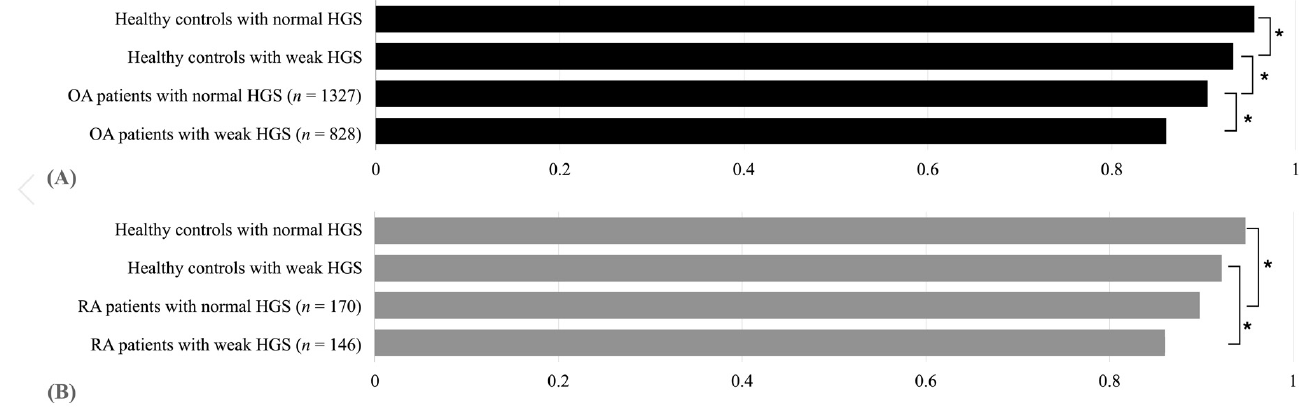
Figure 3. Subgroup analysis of EQ-5D index depending on HGS for patients with osteoarthritis ( A ) and patients with rheumatoid arthritis ( B ). Abbreviations: EQ-D5 European Quality of Life Scale-Five, HGS handgrip strength, OA osteoarthritis, RA rheumatoid arthritis. Adjusted for age, sex, BMI, low income, education ≥ 10 years, high-risk drinking, current smoking, aerobic physical activity, DM, HTN, and hypercholesterolemia levels. p -values were analyzed by Bonferroni post-test after ANCOVA. * p < 0.0083 between the two